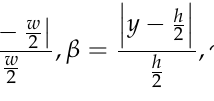
∑ n IoU i = 1. The fusion strategy is adopted to fuse the new defect image D ( x , y ) i = 1